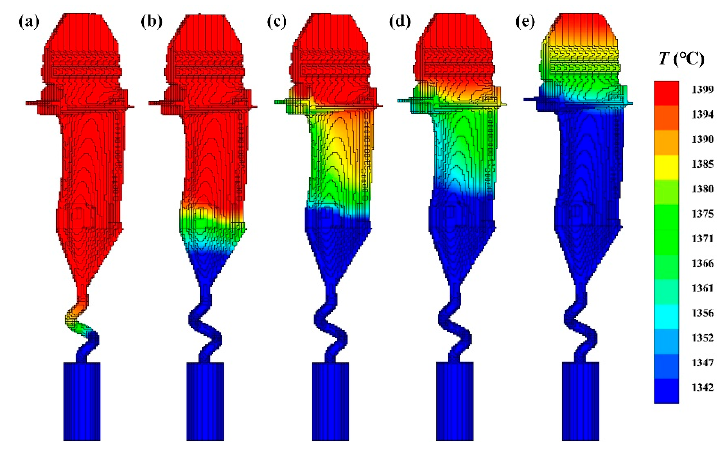
Figure 3. The temperature distribution and mushy zone evolution by the HRS technique at a constant withdrawal rate of 3 mm/min: ( a ) t = 241 s, f s = 30%; ( b ) t = 2028 s, f s = 40%; ( c ) t = 2411 s, f s = 50%; ( d ) t = 2632 s, f s = 60%; and ( e ) t = 2987 s, f s = 80%. In this figure, f s stands for fraction solid.